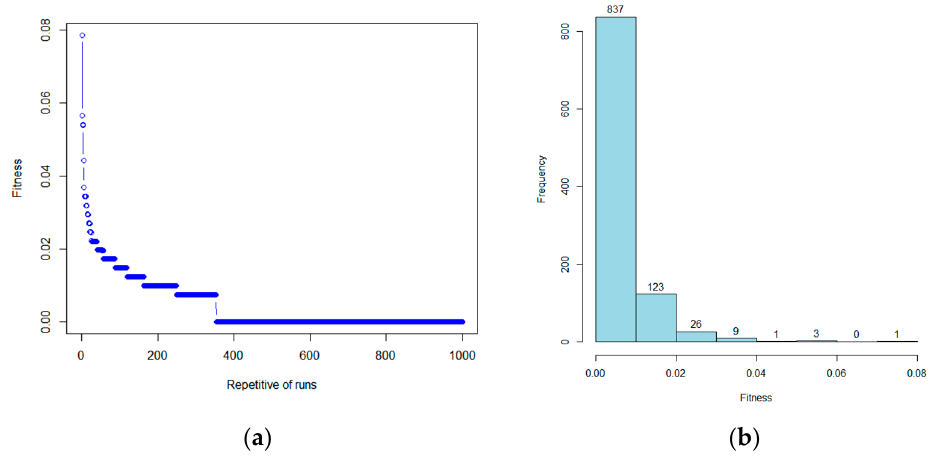
Figure 4. Worst ‐ case analysis with the Griewank (30) function. ( a ) The worst fitness obtained by the CFA program as the number of repetitive runs increases. ( b ) The number of program runs with which each performance level is reached.